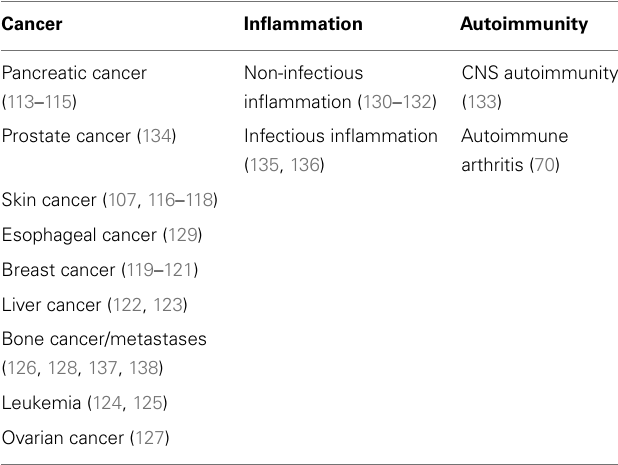
Table 1 | List of experimental studies using 4-MU, broken down by disease type